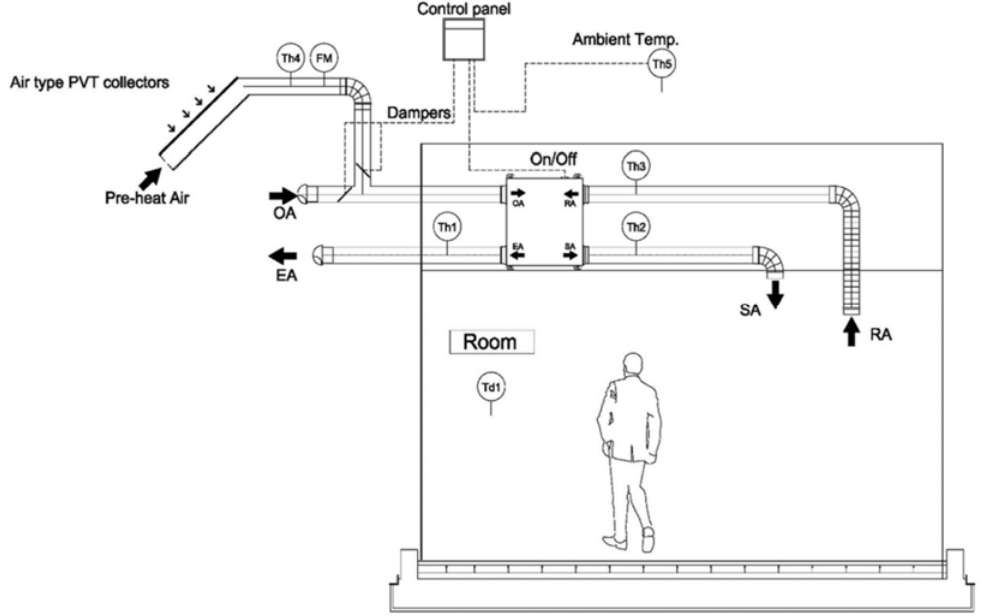
Figure 3. Schematic diagram of the air ‐ type PVT system coupled with the HRV.